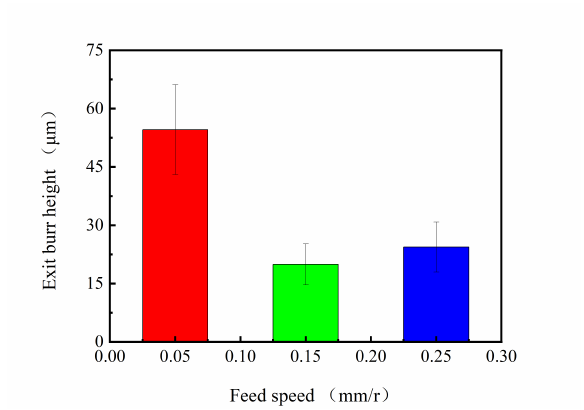
Fig. 8. Effect of the f on exit burr height (v c =120 m/min)